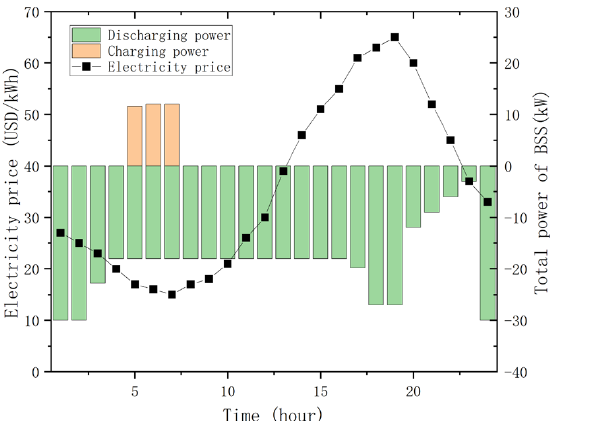
12 of 14 Figure 4. DLMP curve of node 2 in IEEE 33 - bus distribution network and Case 3 . Figure 5a represents the time - varying e lectricity price and charging/discharging power of the BSS in C ase 2. The electricity price is in line with the supply and demand relationship with electricity consumption and decreases with the load reduction in the